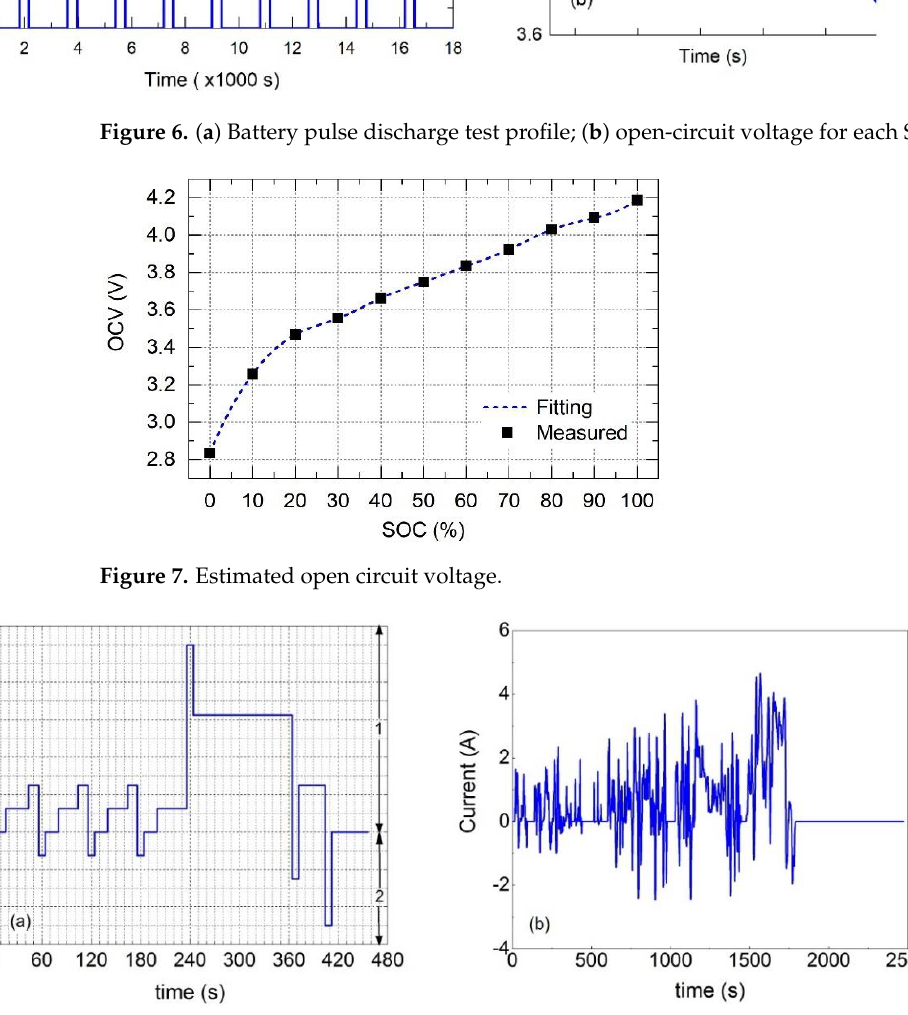
Figure 8. Dynamic test profiles for ( a ) ISO12405-2:2012 (profile B) [36] and ( b ) WLTP (class 3) [37]. The numbers 1 and 2 on the right-hand side in ( a ) represent the discharge and charge processes, respectively.